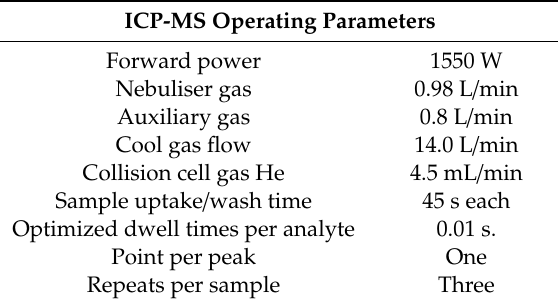
Table 2. The Thermo Scientific iCAP Qc ICP-MS (Inductively Coupled Plasma Mass Spectrometry) operating